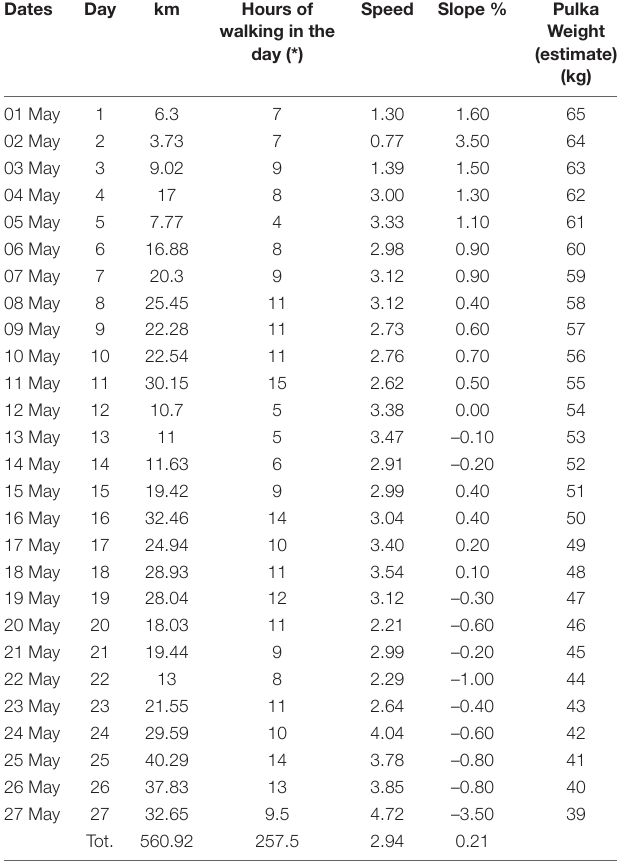
TABLE 2 | Daily characteristics of the